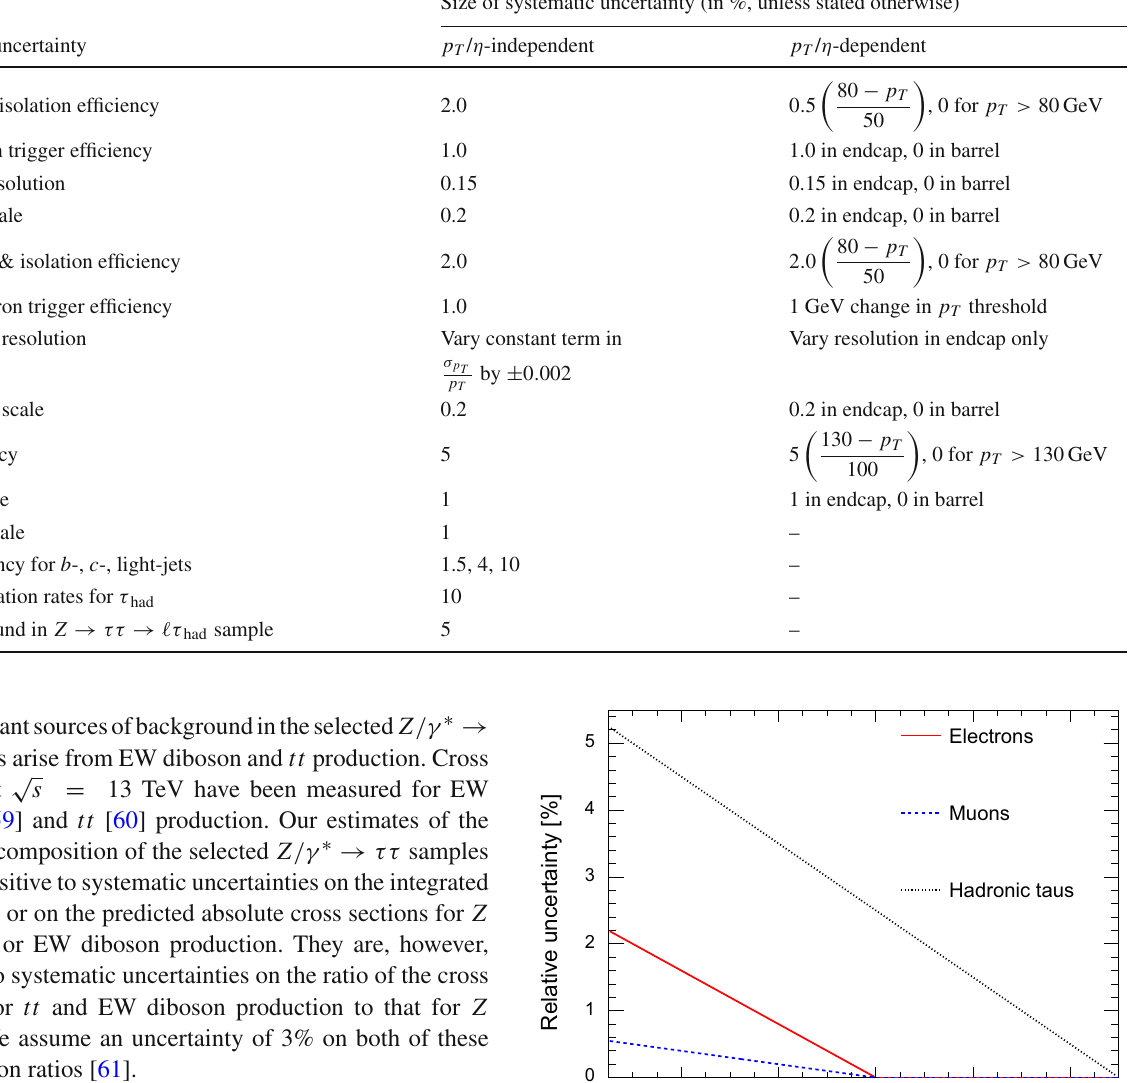
Table 1 Sources of experimental systematic uncertainty, together with the size (in percent, unless stated otherwise) of the p T / η -independent and p T / η -dependent systematic uncertainties considered in this study.